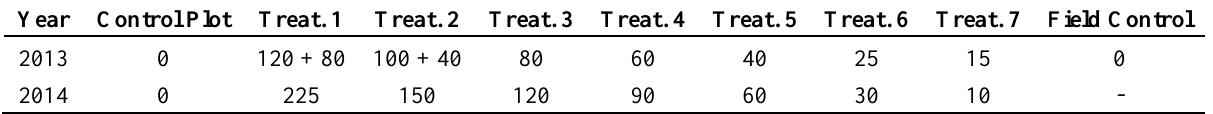
Table 1. Experimental design and irrigation amounts (mm) in 2013 and 2014.